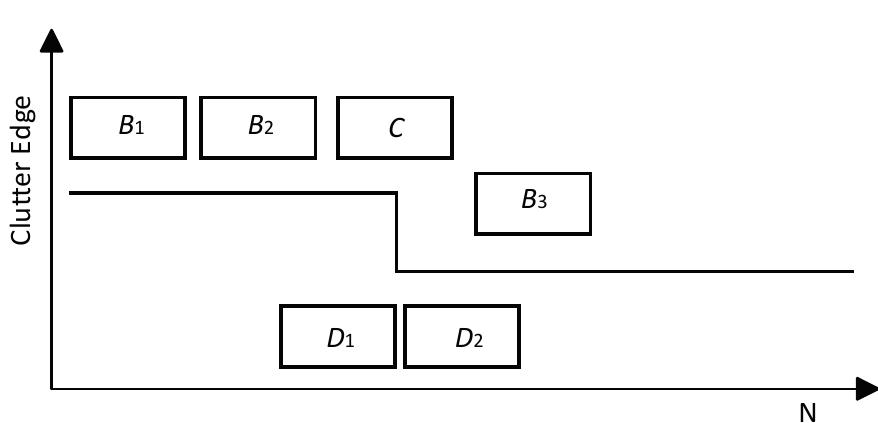
Figure 4. Clutter edge